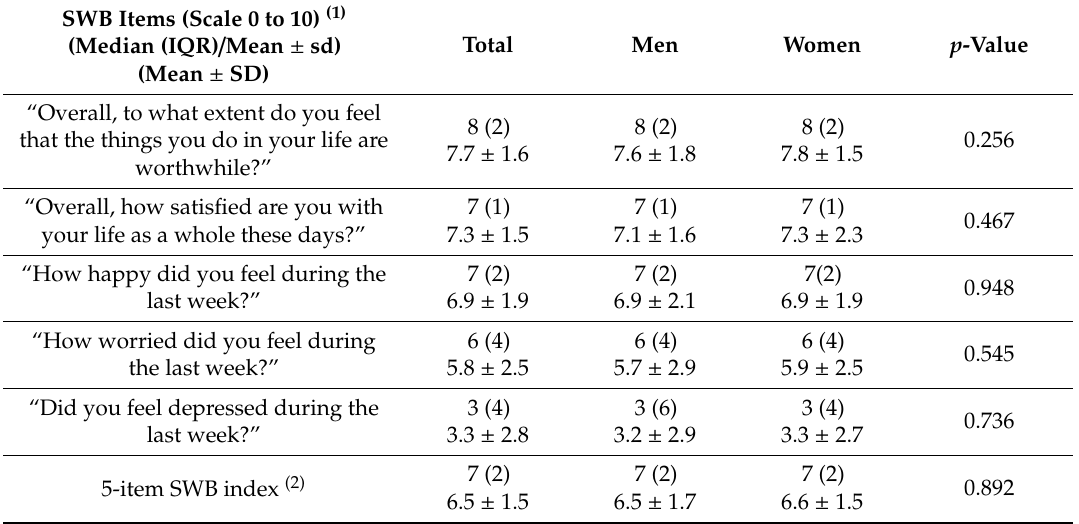
Table 4. Participants’ subjective well-being (SWB) and gender